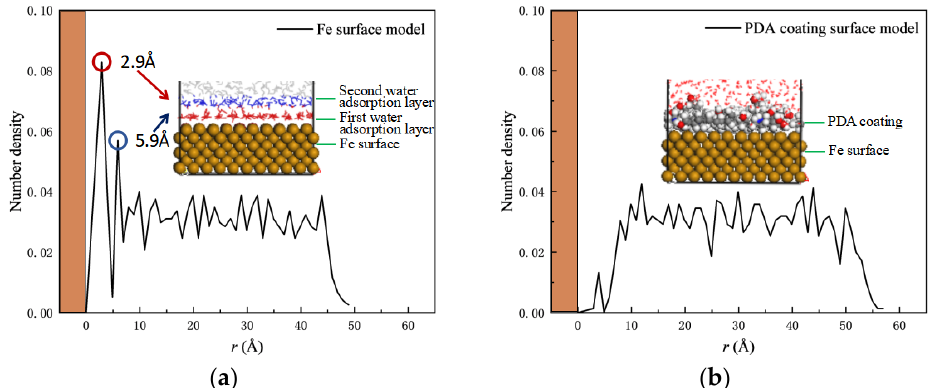
Figure 9. Number density distribution of water molecules oriented perpendicular to the surface. ( a ) Fe plate and ( b ) PDA coating, brown area is Fe plate.